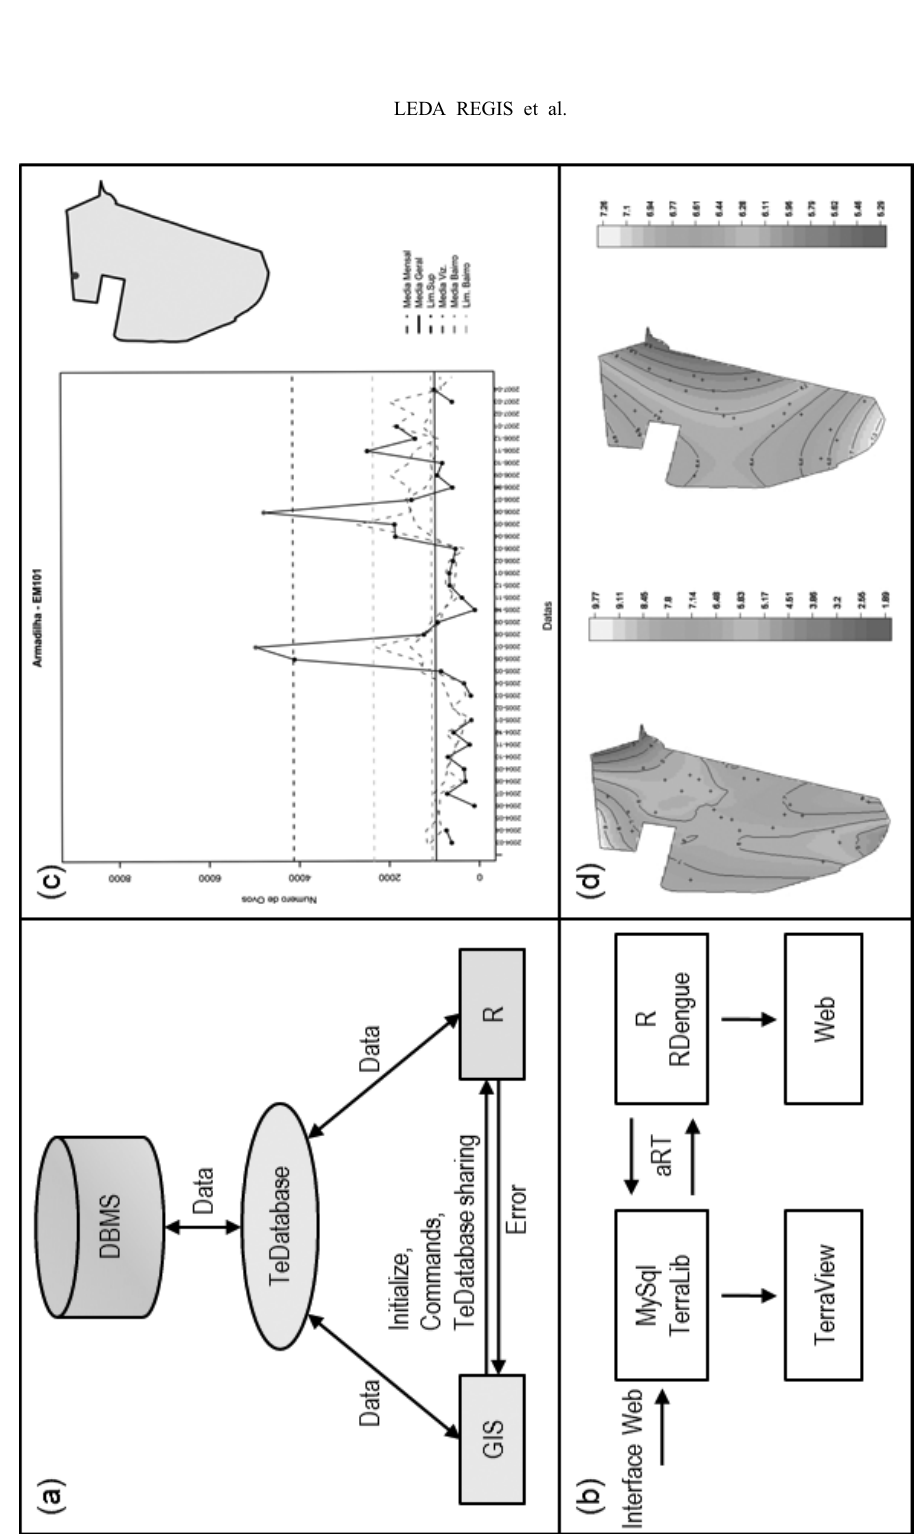
Fig. 3 – (a) A simplified scheme showing the interaction amongst an open DBMS system, the open TerraLib GIS library and the open statistical computing environment R; (b) A schematic view on how the open technologies work together to promote spatial analysis and visualization of the entomological and geographical data; (c) An example of analysis carried out by the RDengue to a specific ovitrap showing its placement and statistical summaries relating the average egg counting on that trap against its neighbors over time; (d) Another example of RDengue possibilities showing a hotspot map for a specific site that displays the estimated vector density based on the ovitraps counting over a certain